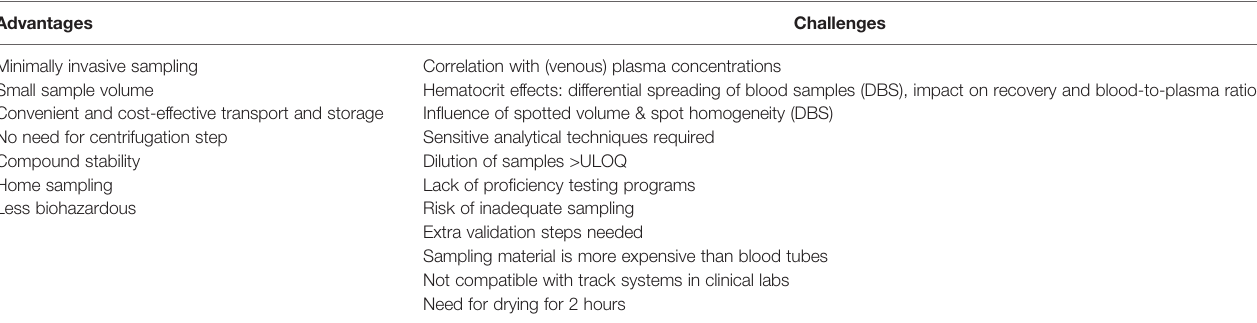
TABLE 1 | Advantages and challenges associated with TKI (dried) microsampling.